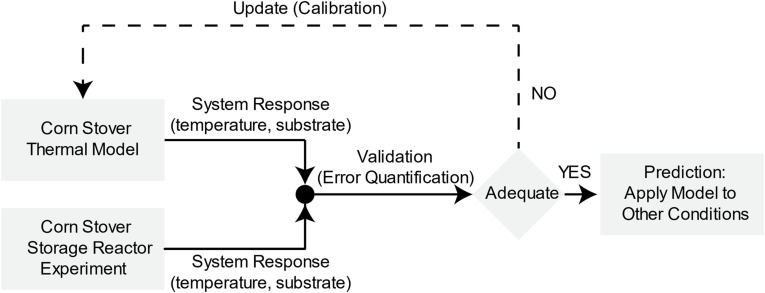
Validation, calibration, and prediction of corn stover storage reactor dynamic thermal system. Adapted from Oberkampf and Barone (2006).